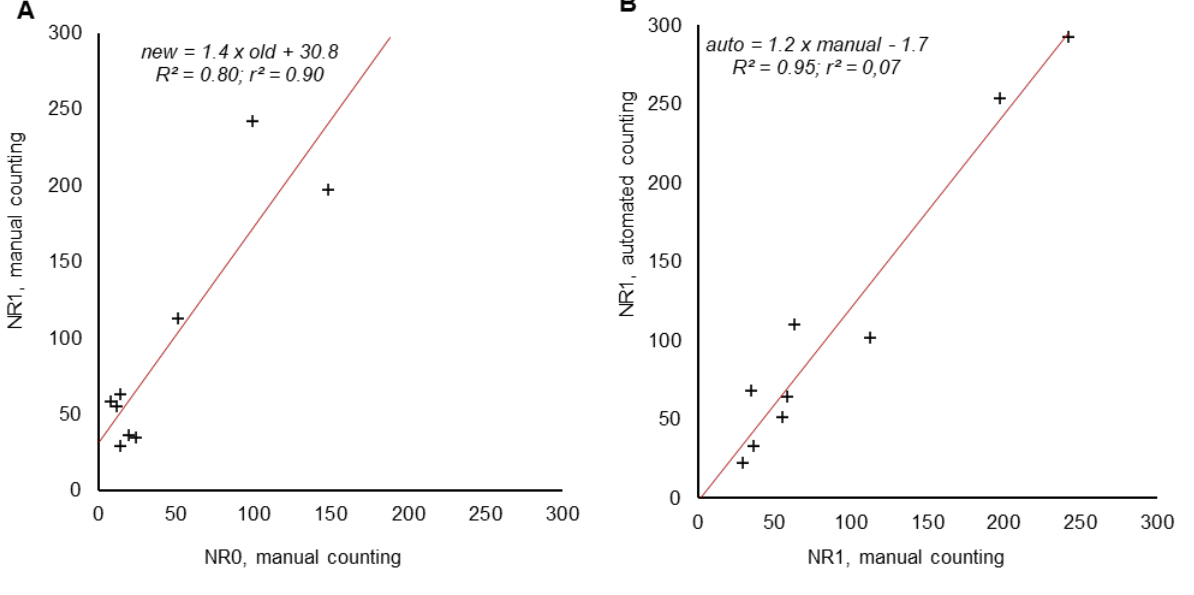
Figure 9. Correlation between the microplastics found in wastewater samples ( A ) with the Nile red (NR0) and the new Nile red derivatives (NR1) and ( B ) the new Nile red derivatives (NR1) with automated and manual particle counting.